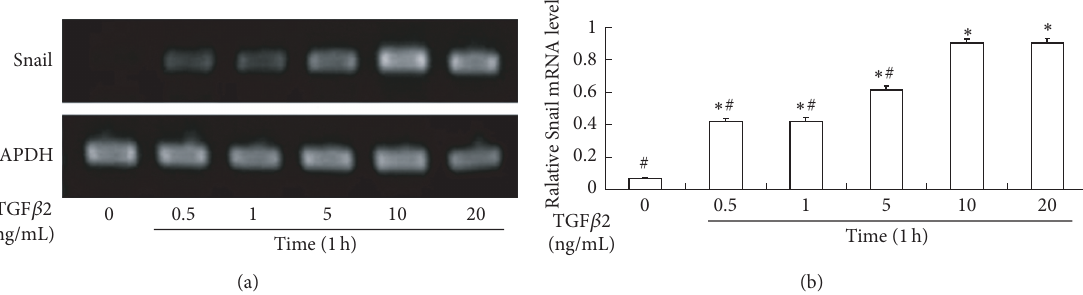
Figure 1: TGF 𝛽 2-induced expression of Snail mRNA in a dose-dependent manner. (a) Representative agarose gel electrophoresis images of Snail and house gene expression after TGF 𝛽 2 treatment. (b) The summary of triplicated experiments. ∗ 𝑃 < 0.05 compared with TGF 𝛽 2 ( − ) (0ng/mL). # 𝑃 < 0.05 compared with the group treated with 10ng/mL TGF 𝛽 2.